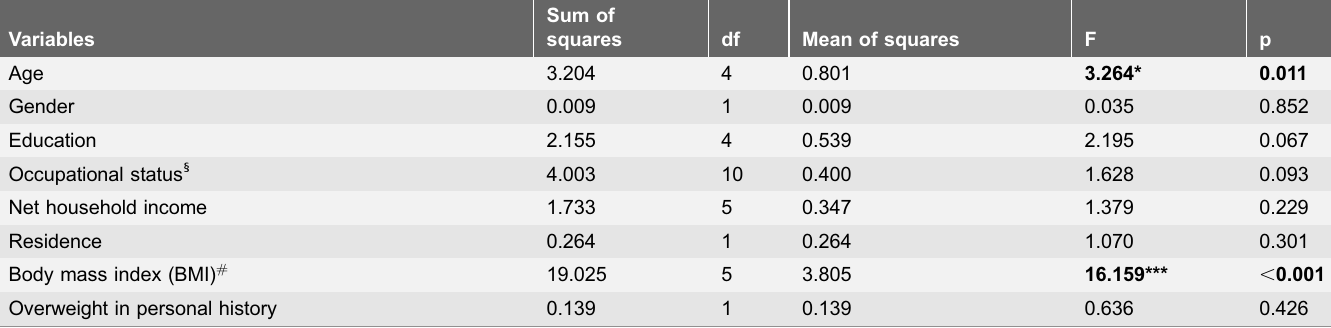
Table 4. Analyses of mean differences between FPS score and socio-demographic factors – results of the analyses of variance (ANOVA) (n 5